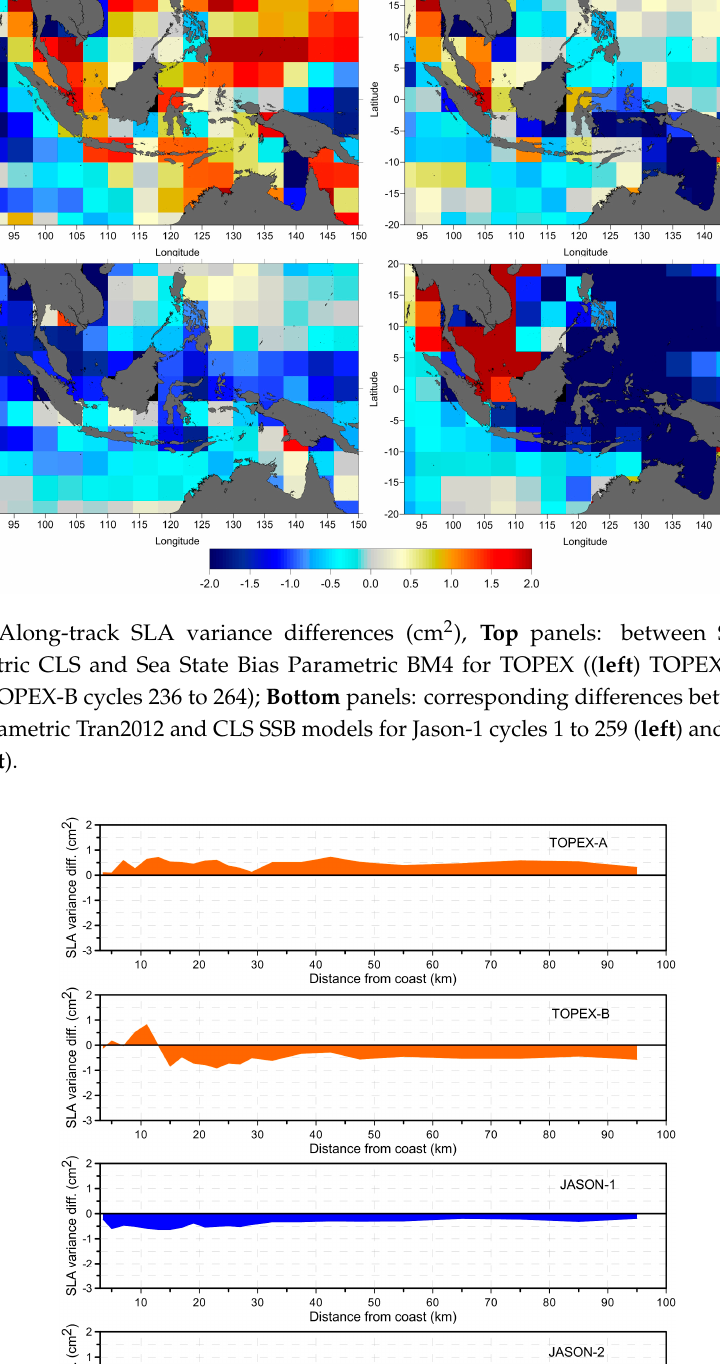
Figure 13. Top panels: SLA variance differences at crossovers (cm 2 ), between Sea State Bias Non-Parametric CLS and Sea State Bias Parametric BM4 for TOPEX (( left ) TOPEX-A cycles 1 to 235; ( right ) TOPEX-B cycles 236 to 264); Bottom panels: corresponding differences between Sea State Bias Non-Parametric Tran2012 and CLS SSB models for Jason-1 cycles 1 to 259 ( left ) and Jason-2 cycles 1 to 280 ( right ).